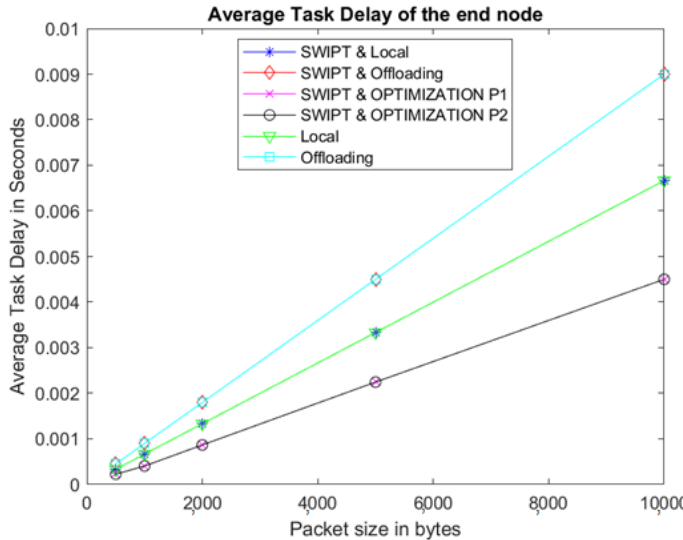
Figure 12. Average task delay of the end node with variable packet